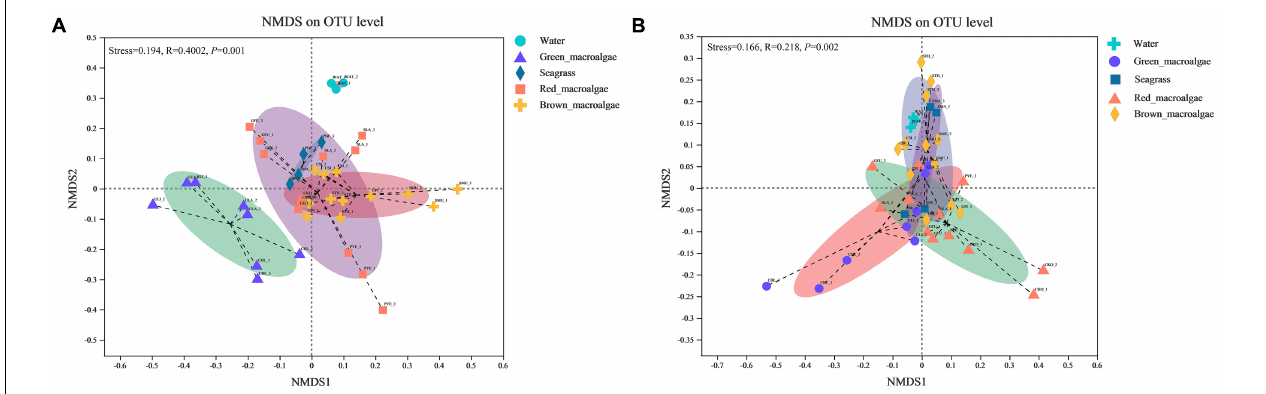
FIGURE 5 | Non-metric multidimensional scaling (NMDS) ordination plot based on Bray–Curtis dissimilarity data. (A) NMDS of bacterial community composition. (B) NMDS of fungal community composition.